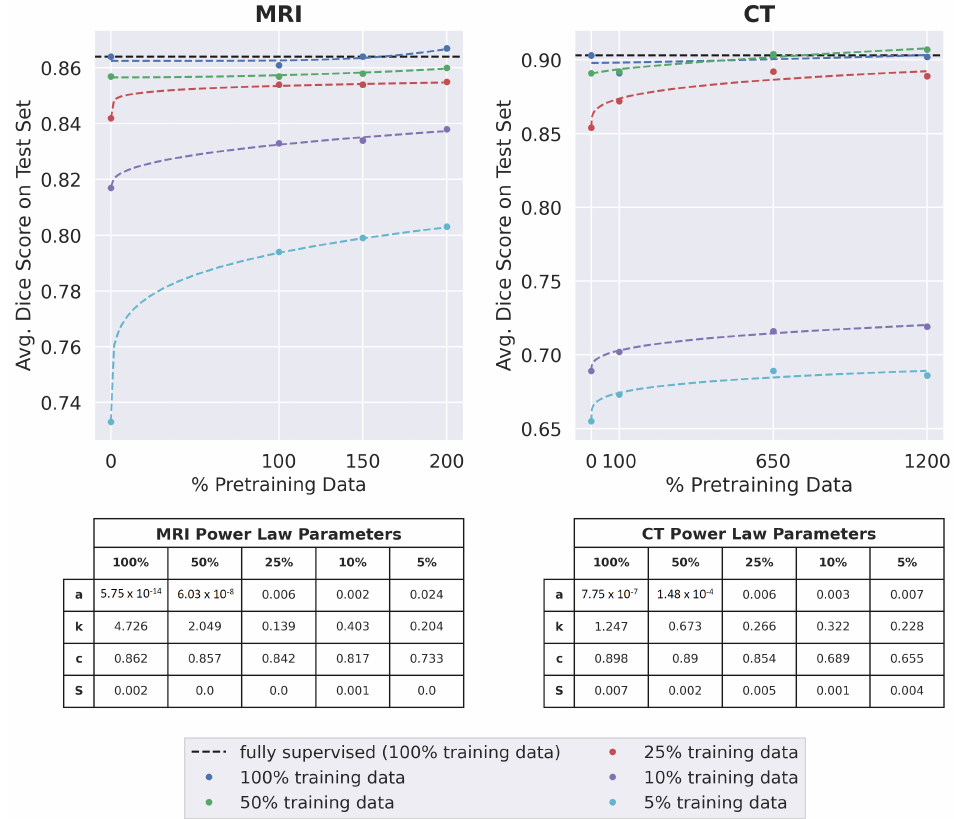
Figure 5. The downstream segmentation performance of the optimally trained model when pretrained with different amounts of pretraining data and fine-tuned using each of the five training data subsets. 100% pretraining data refers to the regular training set for each dataset. The data point for 0% pretraining data is the performance of a fully-supervised model. The black dotted line indicates the performance of a fully-supervised model trained on all available training data for the appropriate dataset. The other dotted lines are the best-fit curves for each of the training data subsets, modeled as a power-law relationship of the form y = ax k + c . The values of a , k , c , and the Residual Standard Error ( S ) for the best-fit curves are displayed in the two